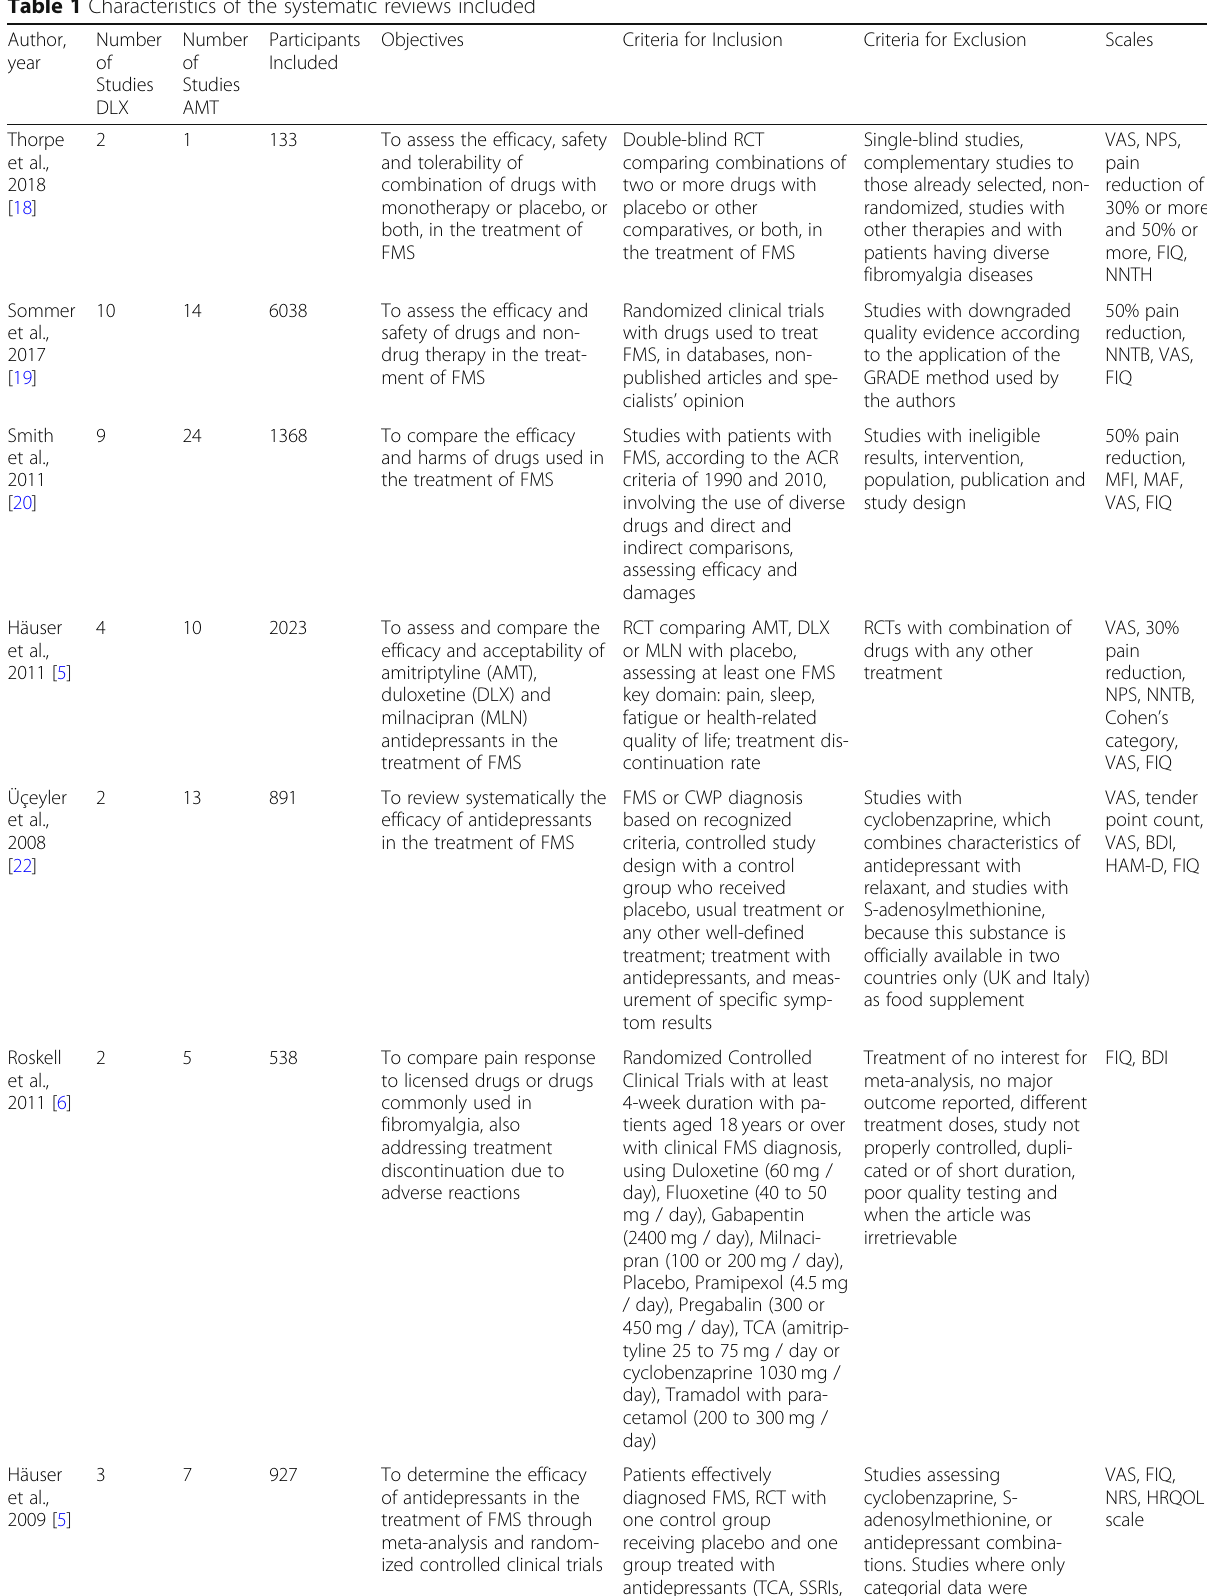
Table 1 Characteristics of the systematic reviews